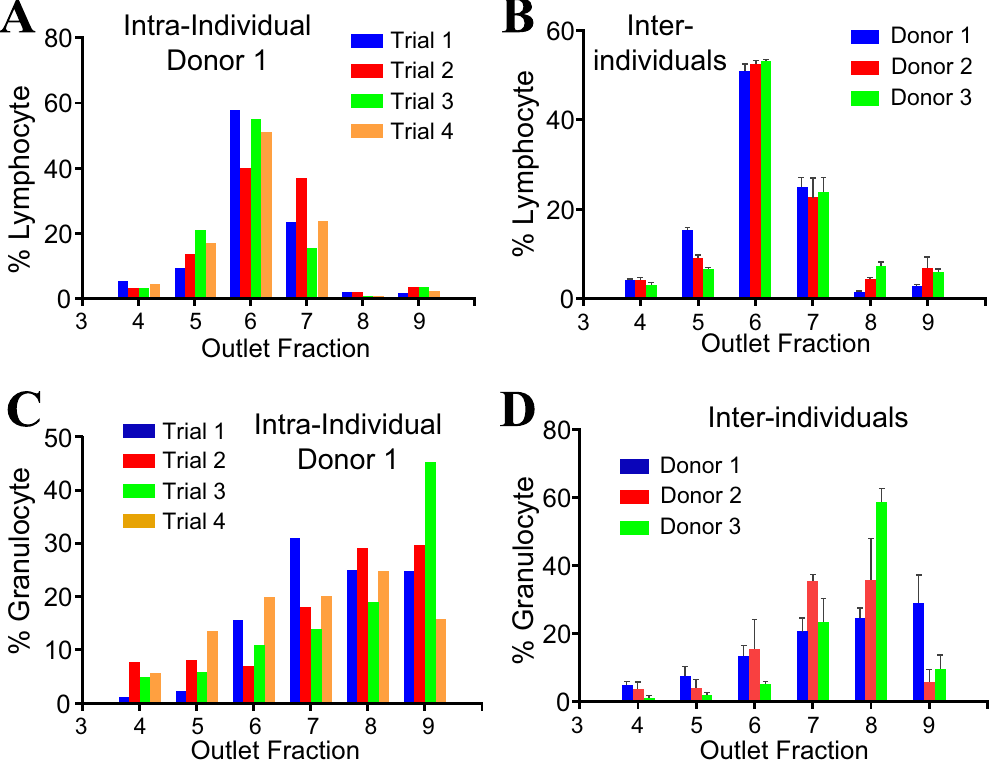
Figure 6. Outlet distributions of lymphocytes and granulocytes. ( A , B ) Outlet distributions of lymphocytes from three donors. ( C , D ) Outlet distributions of granulocytes from three donors. Each inter-individual distribution profile data point is a mean of triplicate experiments. The error bars in Fig. 6B and D represent the standard deviation of results from 3